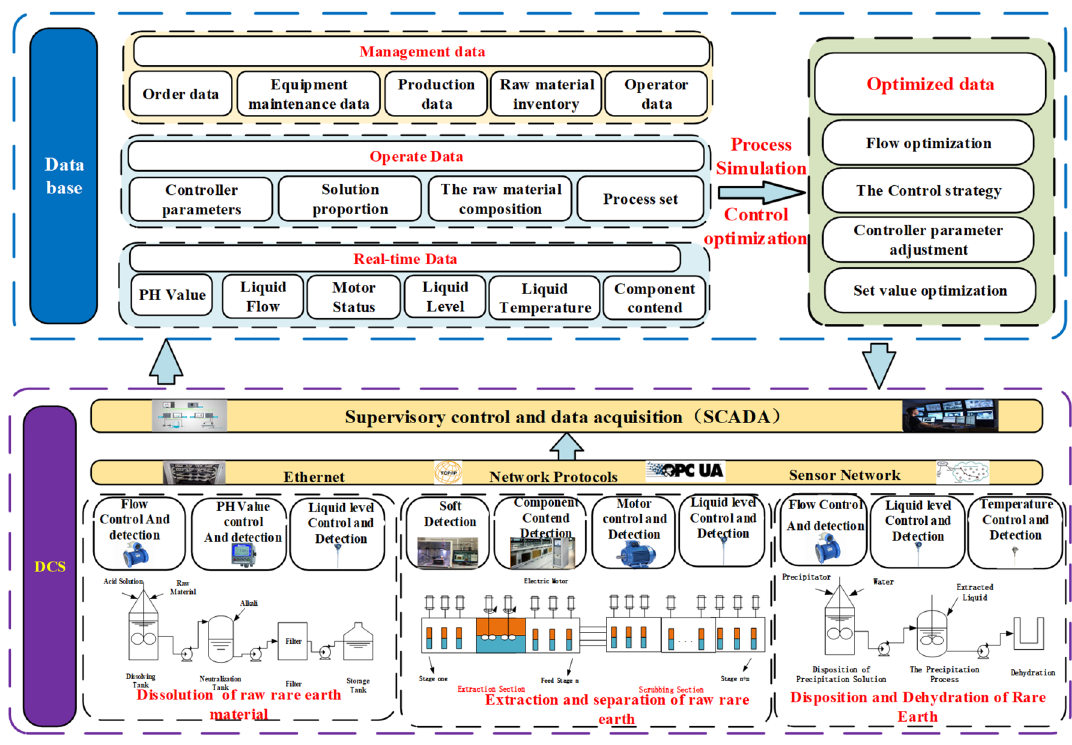
Figure 3. Framework for real-time collection, composition, management data of